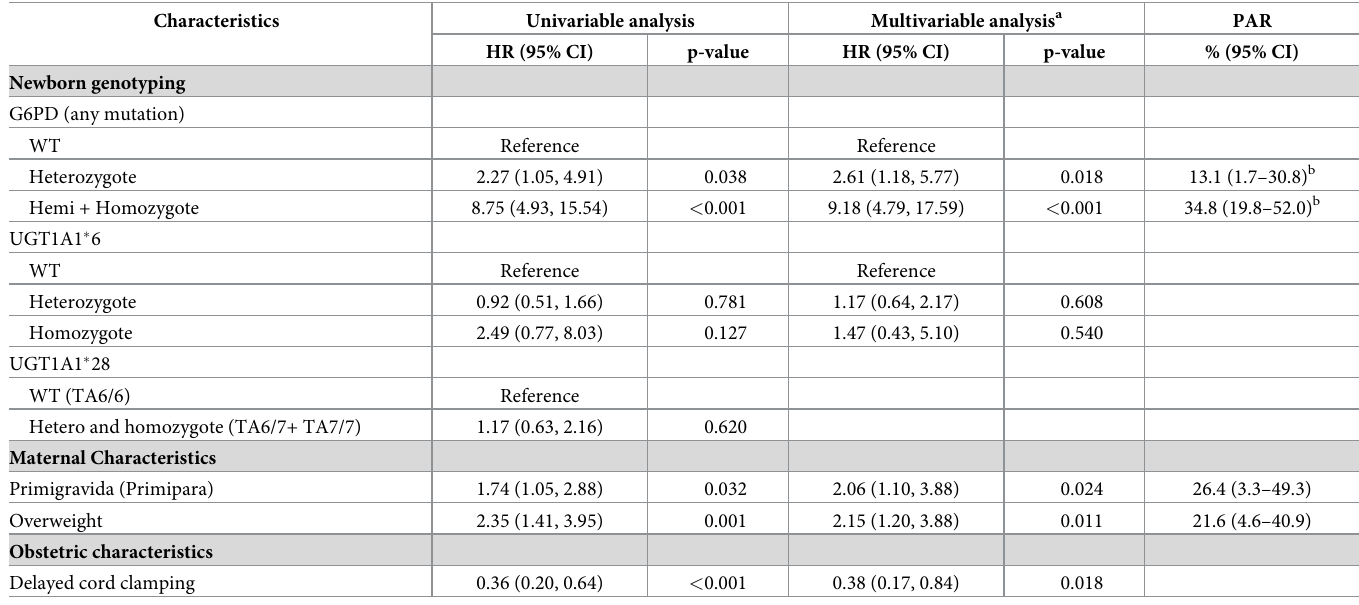
Table 3. Early Neonatal hyperbilirubinaemia (NH) in neonates with EGA � 38 weeks: Uni- and multivariable analysis of genetic factors and other significant risk factors using a mixed effects Cox proportional hazard model clustering by site among neonates who developed NH early (within 48 hours) and neonates who did not develop NH in the first week of